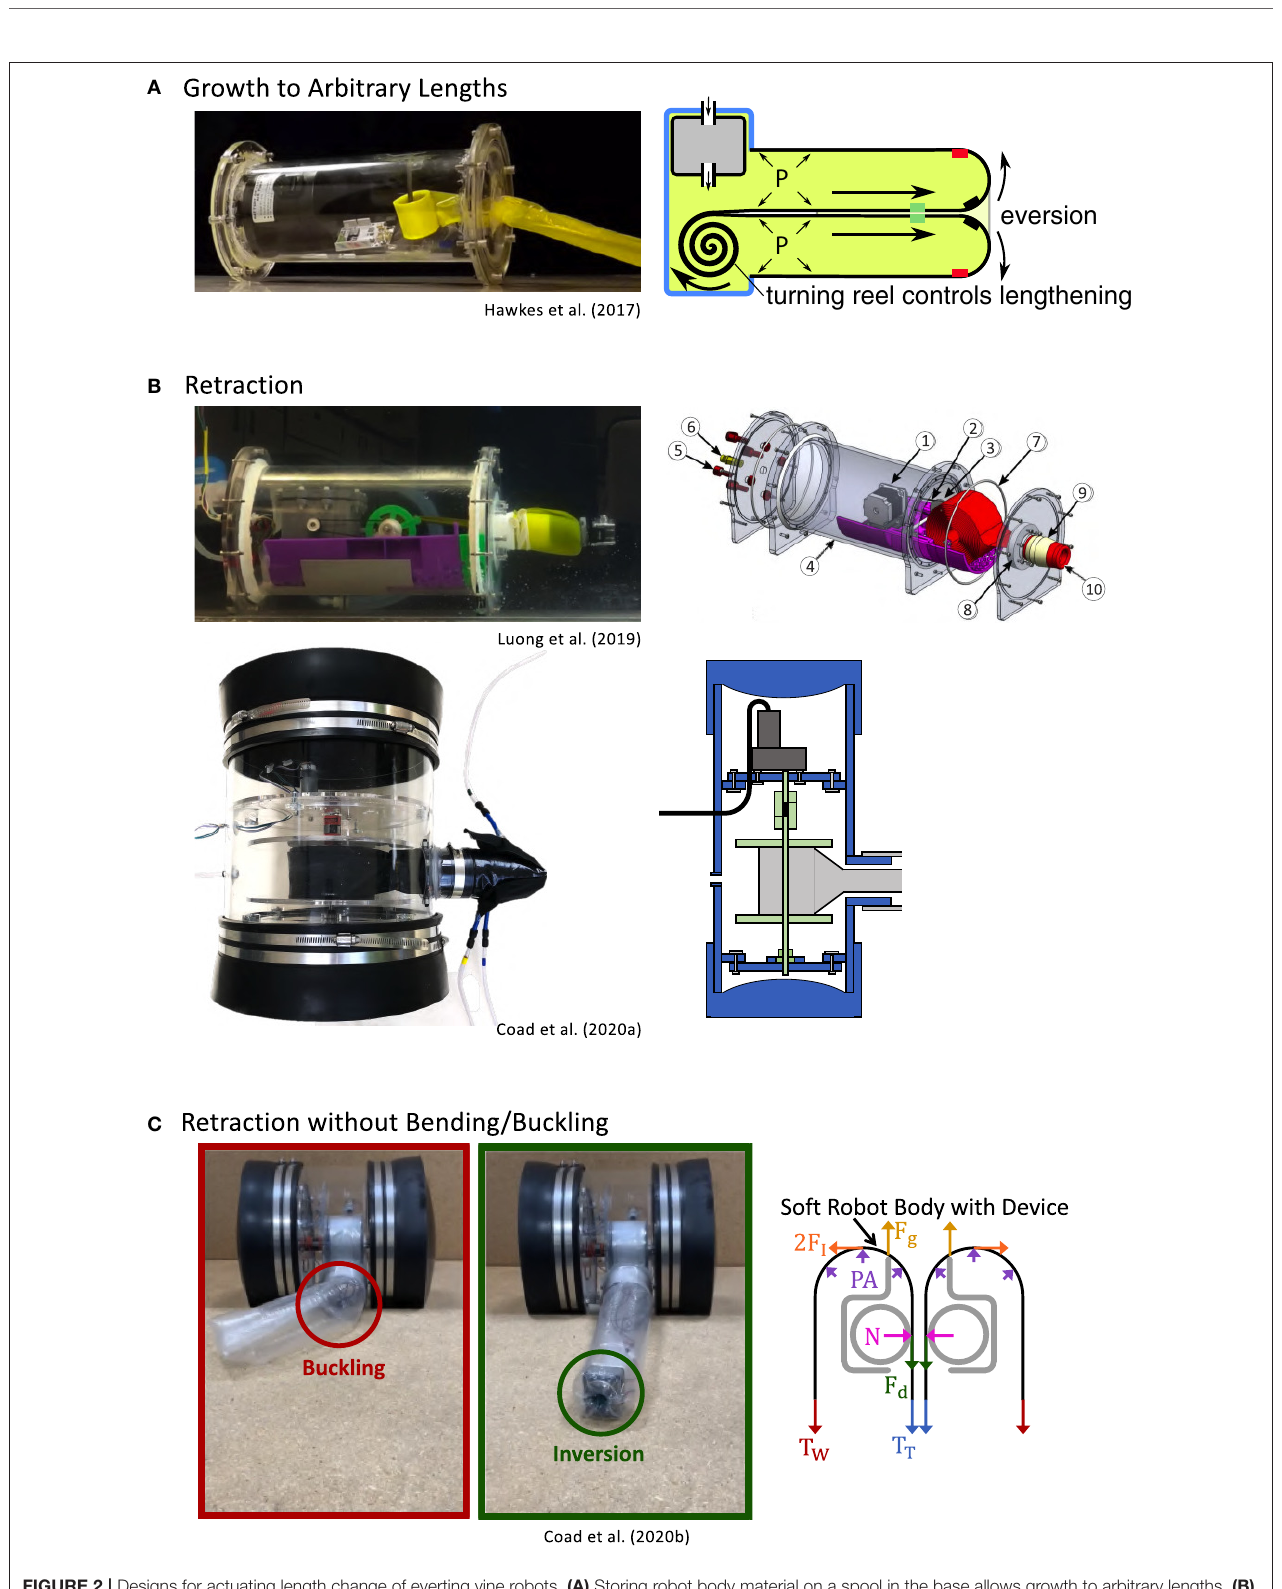
Frontiers in Robotics and AI |